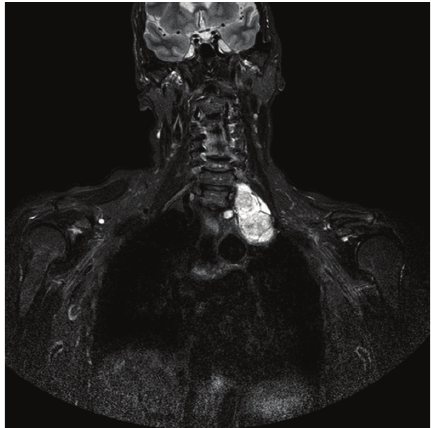
Figure 2: Magnetic resonance imaging (MRI) showing a left posterior mediastinal schwannoma extending to the cervical region through the thoracic inlet.